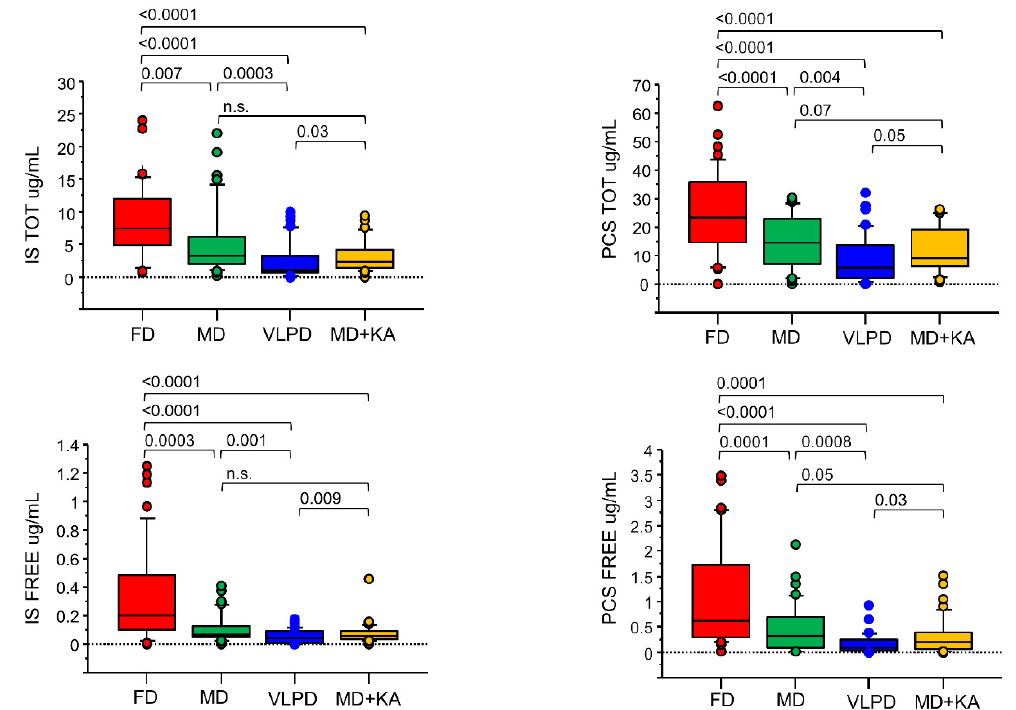
Figure 4. Serum levels of IS and PCS measured by multiple-reaction-monitoring mass spectrometry analysis. Serum levels of IS and PCS in CKD patients in accordance with the different diets (Table 1). p values were calculated by the Wilcoxon test.